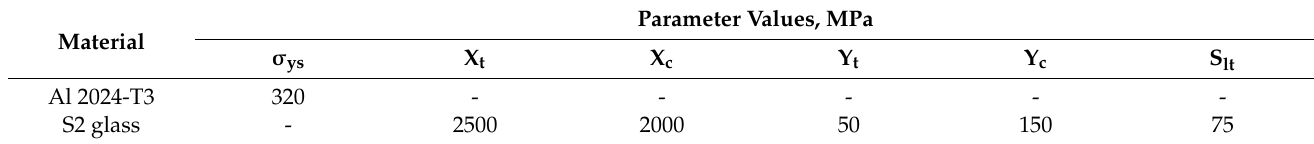
Table 2. Damage and failure properties used in the finite element model